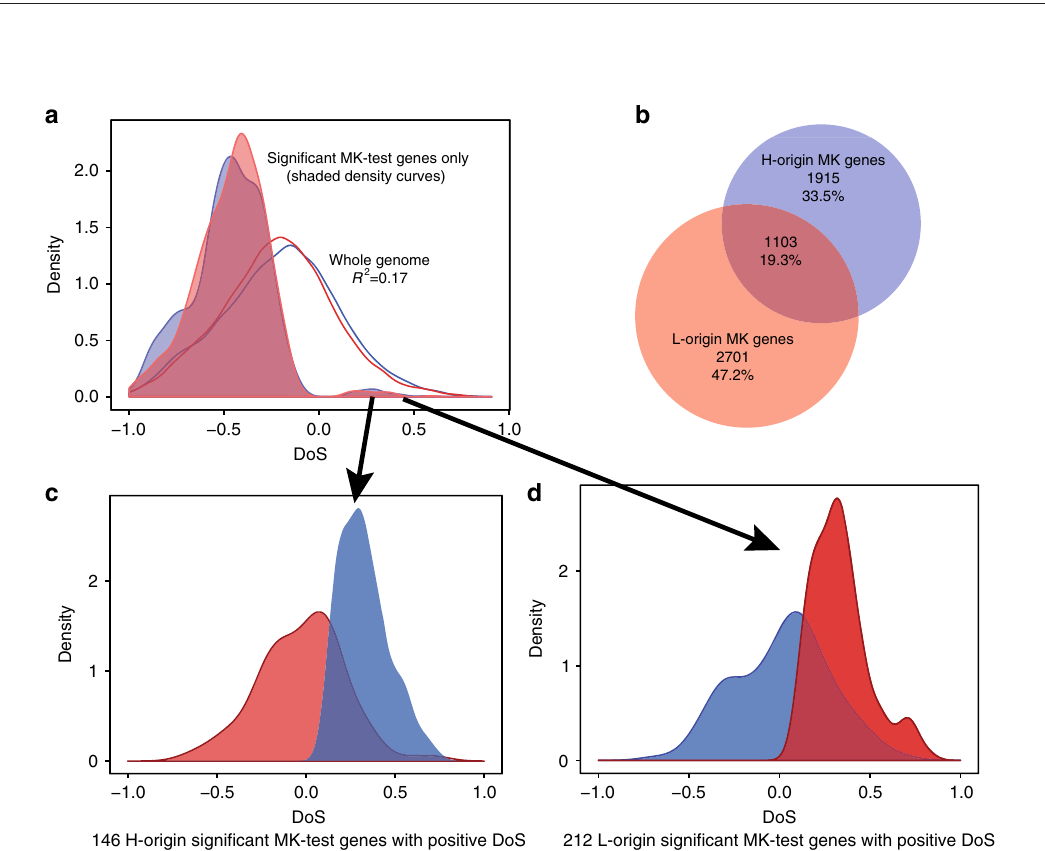
Fig. 2 Genetic diversity of the syntenic HMA4 region. a Synteny of the HMA4 region from A. halleri v2.2 38 , A. lyrata subsp. petraea v2.2, A. lyrata subsp. lyrata (JGI) 70 , and A. thaliana (TAIR). b Nucleotide diversity ( π ) of genes surrounding the HMA4 region in both homeologs of A. kamchatica . c For the halleri subgenome, genetic diversity of NBS-LRRs is signi fi cantly greater (two asterisks below, ** p < 0.001, Wilcoxon signed-rank test) than the background genetic diversity, whereas heavy metal (HM) genes show no signi fi cant difference. Diversity for both HMA4-L ( π = 0.0018) and HMA4-R ( π = 0.004) are signi fi cantly higher than the HMA4-M (which contains the HMA4 coding sequences) region (two asterisks above HMA4-M, ** p < 0.001, Wilcoxon signed-rank test). d For the lyrata -subgenome, diversity of NBS-LRRs, HMA4-M, and HMA4-R are all signi fi cantly higher than the background. The diversity of the lyrata HMA4-M ( π = 0.0032) region is also signi fi cantly greater than the halleri HMA4-M region ( π = 0.0007, paired t -test p -value = 0.003; Wilcoxon signed-rank p -value = 0.0001). e The neutrality statistics (Tajima ’ s D , Fu and Li ’ s D *, and Fu and Li ’ s F *) all show the halleri -origin HMA4- M region to be signi fi cantly lower than the left- and right- fl anking regions, supporting genetic hitchhiking surrounding the HMA4 coding sequences. Boxplots show center line: median; box limits: upper and lower quartiles; whiskers: not greater than 1.5 times the interquartile range; points: outliers